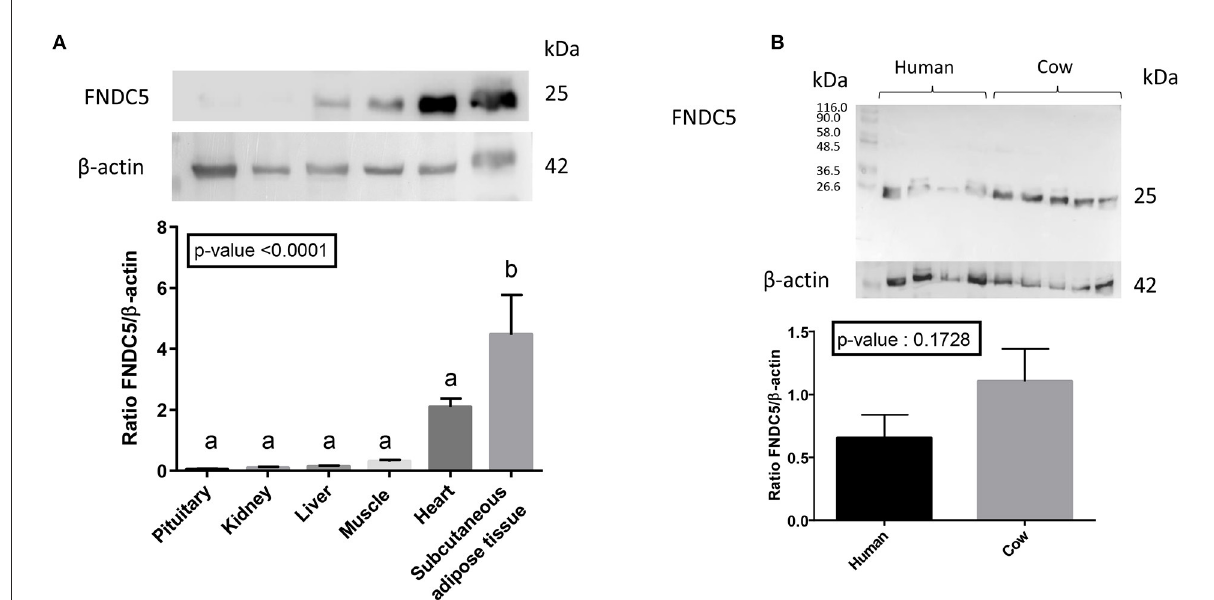
FIGURE4 Protein expression of FNDC5 in different bovine tissues. (A) Abundance of FNDC5 protein was determined by western blot in tissues obtained from an abattoir. A representative blot is shown above the means. Data are expressed as mean ± SEM for each group ( n = 7) and analyzed by one-way analysis of variance (ANOVA). (B) Bovine ( n = 5) and human ( n = 4) abdominal subcutaneous adipose tissues were examined for full-length (25 kDa) and cleaved (12 kDa) forms of FNDC5/irisin.